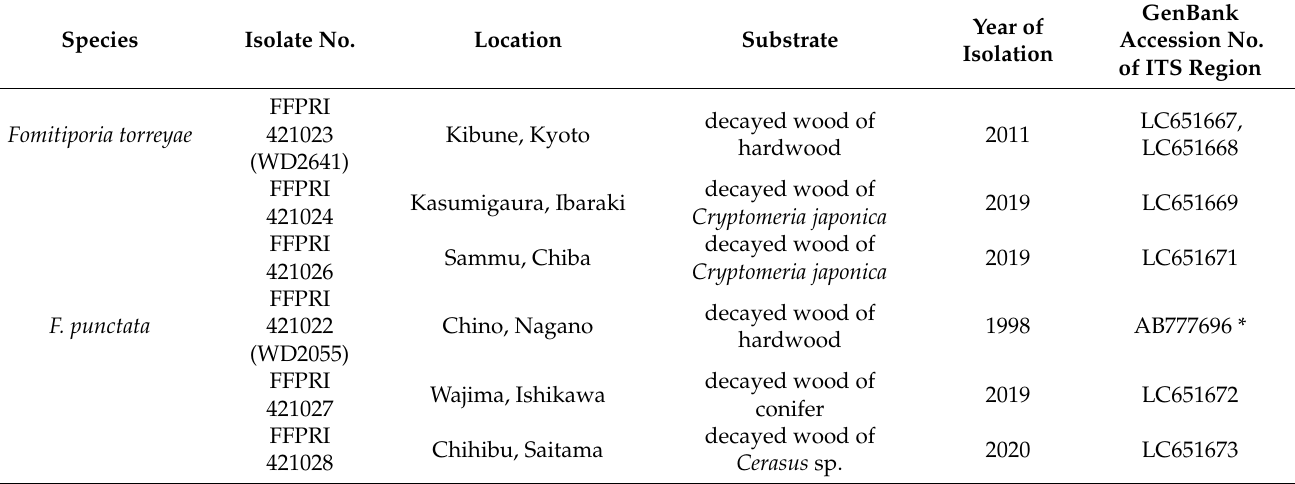
Table 1. Origins of Fomitiporia torreyae and F. punctata isolates used in growth experiments.